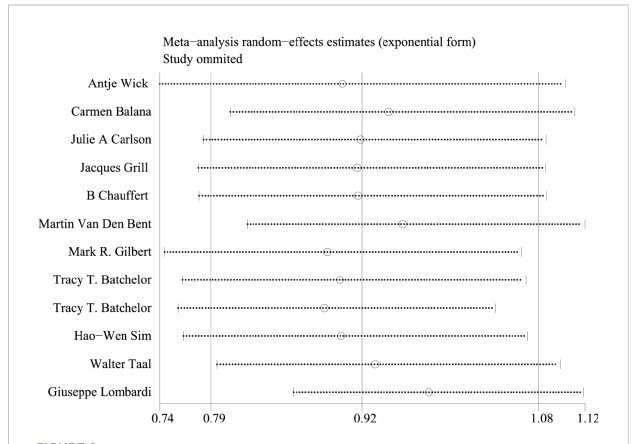
FIGURE 9 Sensitivity analysis of hazard ratios for overall survival (OS).